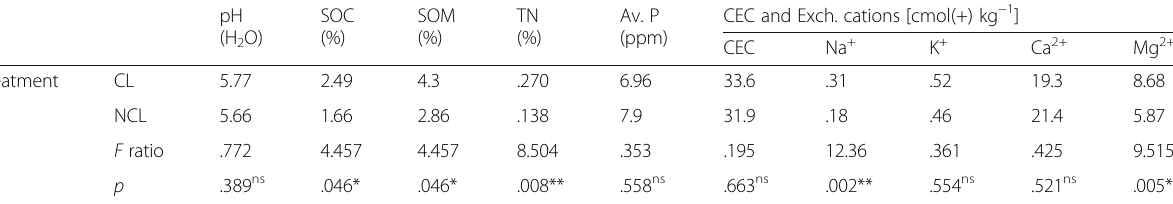
Table 3 The mean and their significant variations (one-way ANOVA) of soil chemical properties in conserved and non-conserved plots pH (H 2